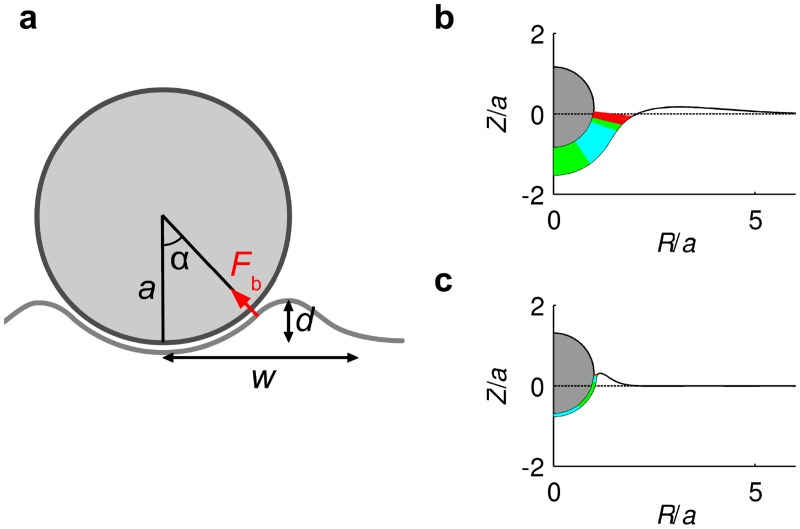
Illustration of the particle wrapping process.
a. Schematic illustrating the geometric parameters used in the scaling arguments. b. Snapshot of the internalization geometry for a particle of radius a = 30 nm at the time when d/(2a) = 0.5. c. Snapshot of the internalization geometry for a particle of radius a = 300 nm at the time when d/(2a) = 0.5.